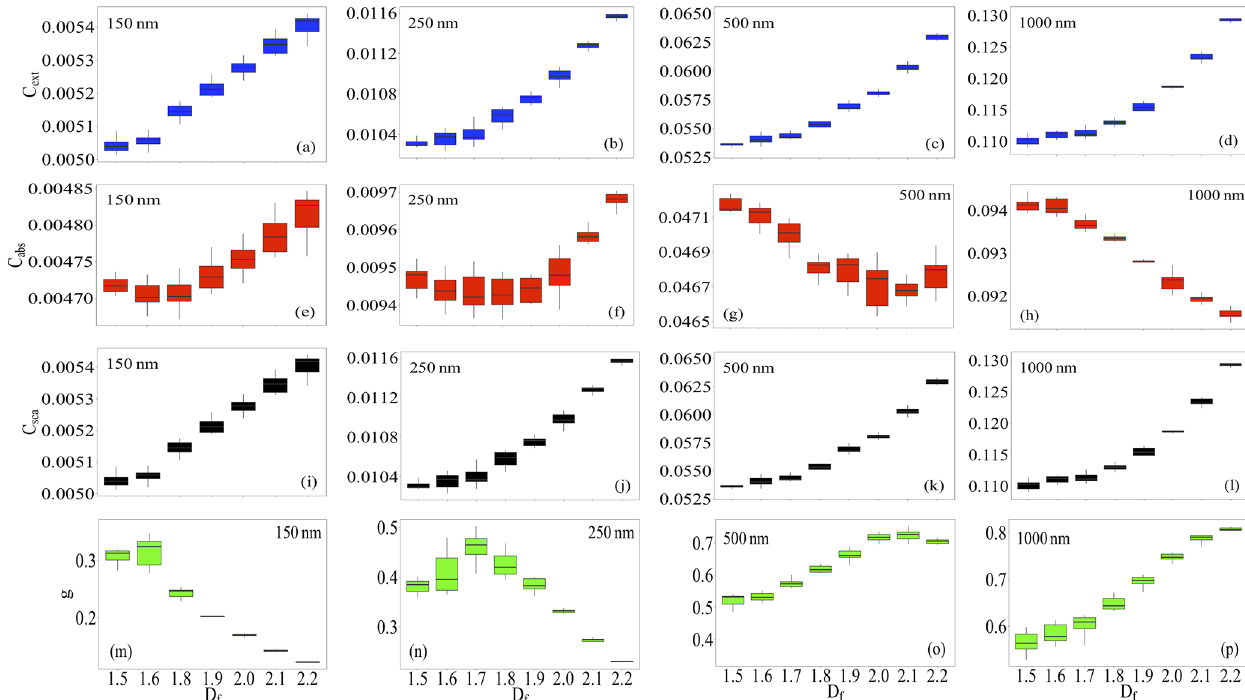
Figure 4. The variability in the optical properties at λ = 660nm for 30 representations of pure BCFAs with D mob increasing (left to right). The panels show the extinction cross section C ext (first row), absorption cross section C abs (second row), scattering cross section C sca (third row), and asymmetry parameter g (fourth row). The box plots show the interquartile range between the 75th and 25th percentile, with the centre bar in the box indicating the median. The whiskers on the top and bottom of the box plot mark the largest and smallest value within 1.5 times the interquartile range.